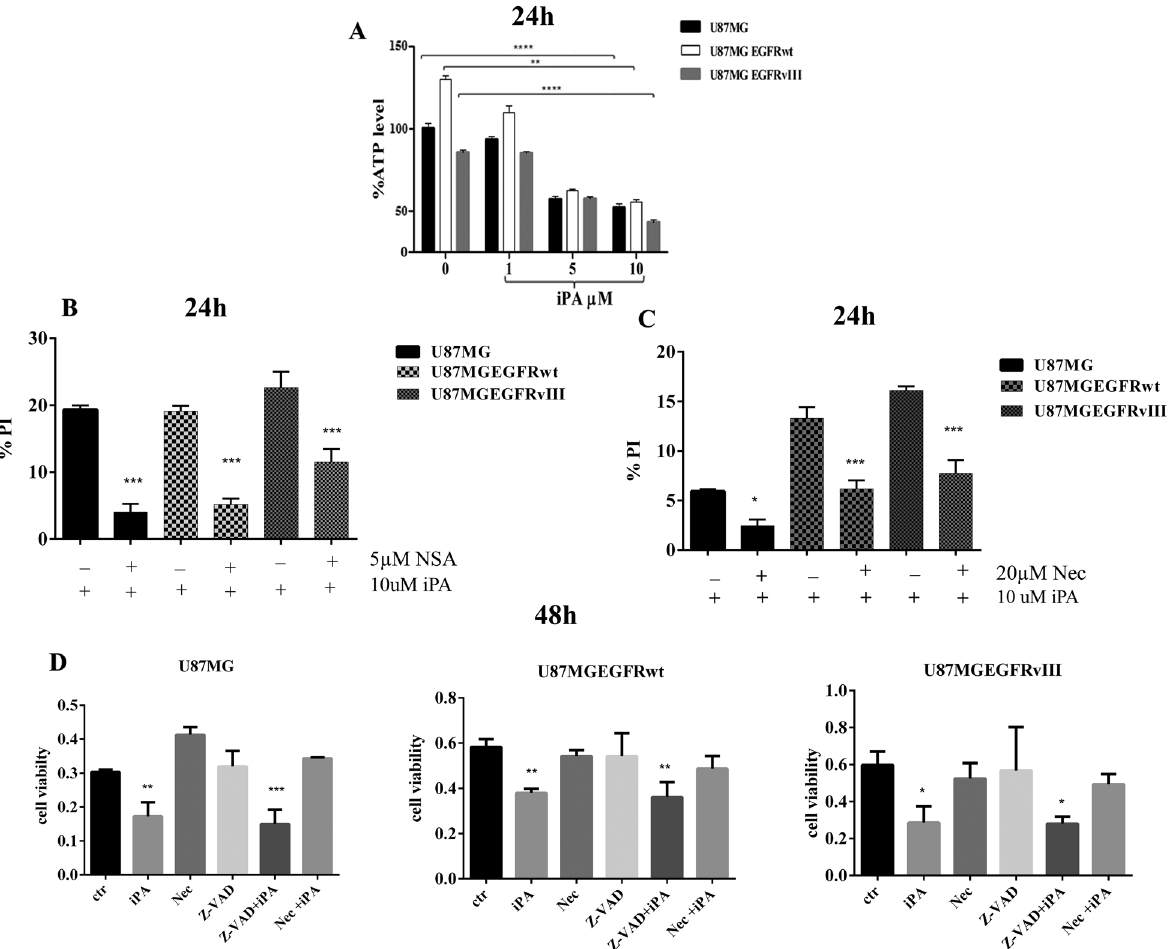
Fig. 3 iPA induces necroptosis. A Plot showing the reduced ATP levels after 24 h of treatment with iPA 10 µM in U87 GBM stabilized cell lines. B , C Plot showing the % of PI-positive cells. Stabilized GBM cell lines were pretreated for 1 h with Necrosulfonamide (NSA) (5 μ M) ( B ) and Necrostatin-1 (Nec-1) (20 μ M) ( C ) and then analyzed through PI staining after 24 h of iPA treatment (10 μ M). D Plot showing the % of cell viability in U87 GBM cell lines after 48 h of treatment with iPA (10 μ M), RIP1 inhibitor Nec-1 (20 μ M), Caspase inhibitor z-VAD (10 μ M), and two combinations of these drugs: z-VAD (10 μ M) + iPA (10 μ M) and Nec-1 (20 μ M) + iPA (10 μ M). Speci fi cally, GBM cells were pretreated with z-VAD or Nec-1 for 1 h, followed by treatment with iPA 10 μ M for 48 h. The data are presented as mean ± SD of at least three